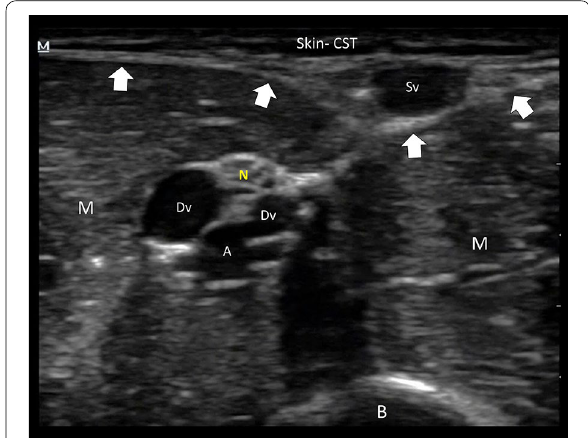
Fig. 2 Ultrasound anatomy applied to cannulation of the peripheral veins of the upper limbs. Superficial veins (Sv) are found above fascia (delineated by arrows) in the cellular subcutaneous tissue (CST), and deep veins below fascia, or subfascial. As noted, deep veins are paired (brachial veins in this case), and are accompanied by an artery (A, brachial artery in this example) and a nerve (N, median nerve in this case) in the neurovascular bundle. The muscle (M) and the bone (B) are also found in the subfascial compartment. Superficial veins should be selected for cannulation